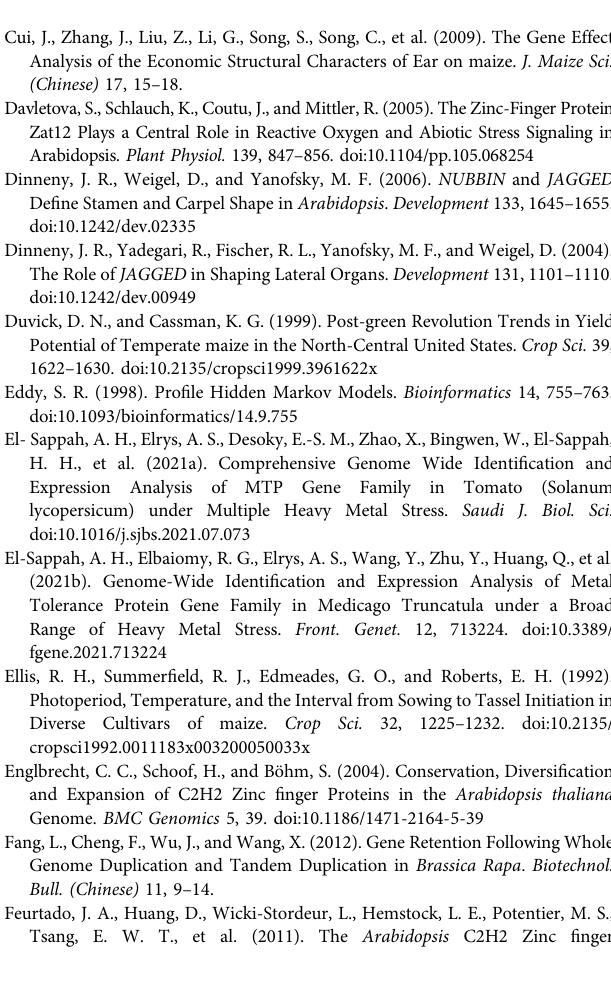
SupplementaryFigure1 |Expressionpro fi lesofC2H2-ZFgenesineleventissueor organs across maize different developmental stages. The red, green, and black represent high, low, and medium gene expression, respectively. Supplementary Figure 2 | ZmZFP126 -based association mapping and LD analysis in 109 diverse maize inbreds. (A) : Circle and triangle indicate SNPs and Indel site, respectively, and red circle and triangle represent signi fi cant sites. The P-value is shown on a − log10 scale. (B) : A schematic diagram of the entire gene structure is presented as the x-axis, including white and black boxes showing as UTRs and exons, respectively. (C) : The pattern of pairwise LD of DNA polymorphisms in the ZmZFP126 gene. The color re fl ects the level of LD ( r 2 ), and all polymorphic sites (MAF ≥ 0.05) are used. (D) : Decay speed of LD in the ZmZFP126 gene. The x-axis indicated a full-length